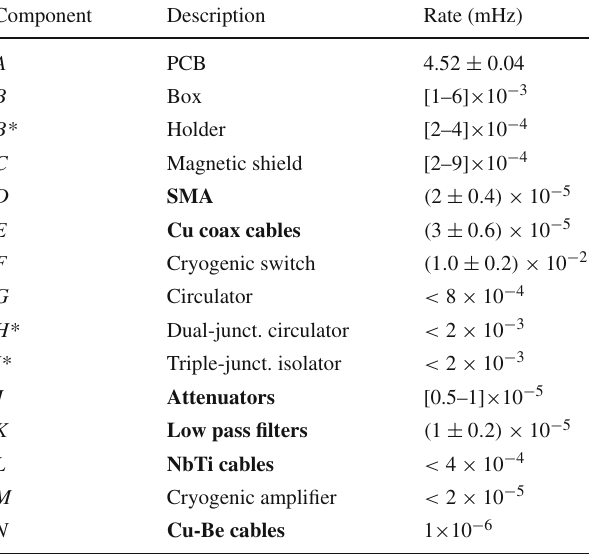
qubit measurements, with the exception of the PCB.